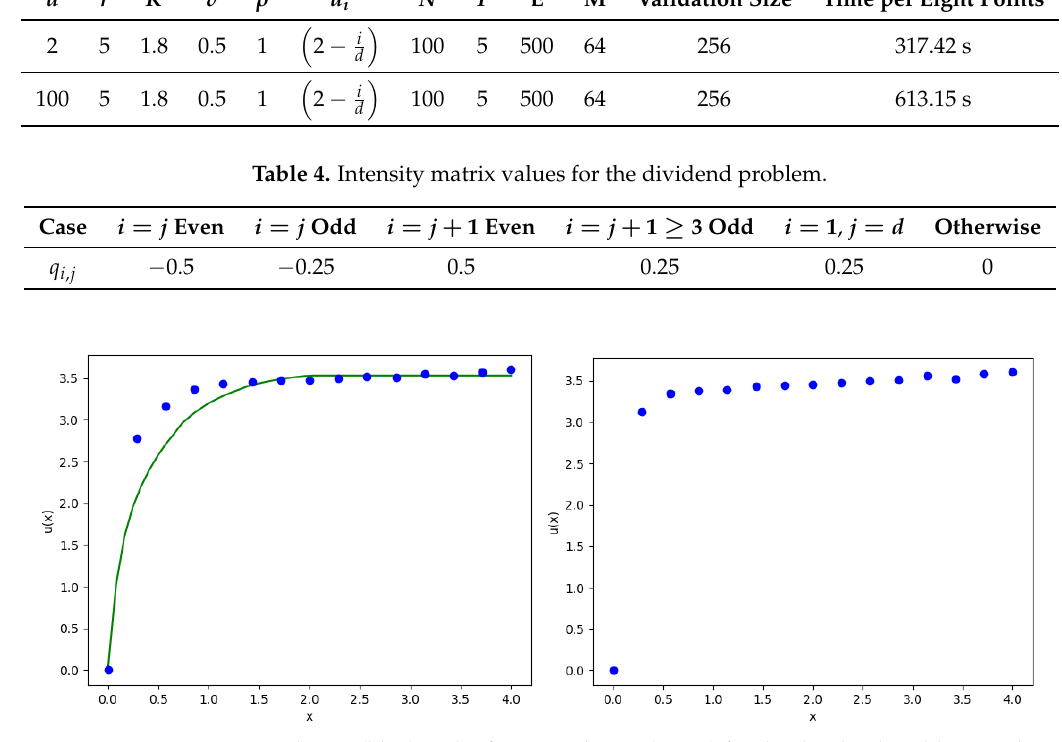
Figure 3. Approximate solution (blue) and reference solution (green) for the dividend problem on the R 2 for fixed π = π = 0.5 ( left ) and on the R 100 for fixed π 2 1 reference solution).